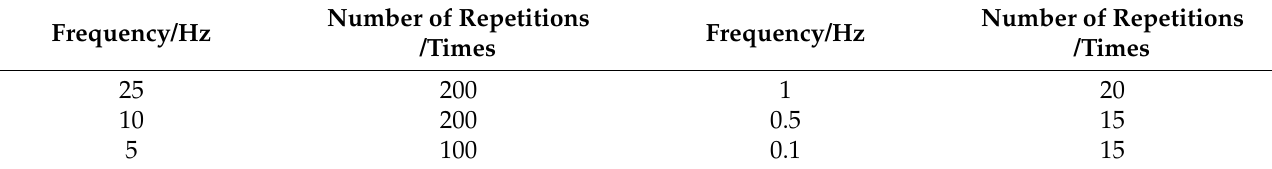
Table 4. Repetitions of loading under various load